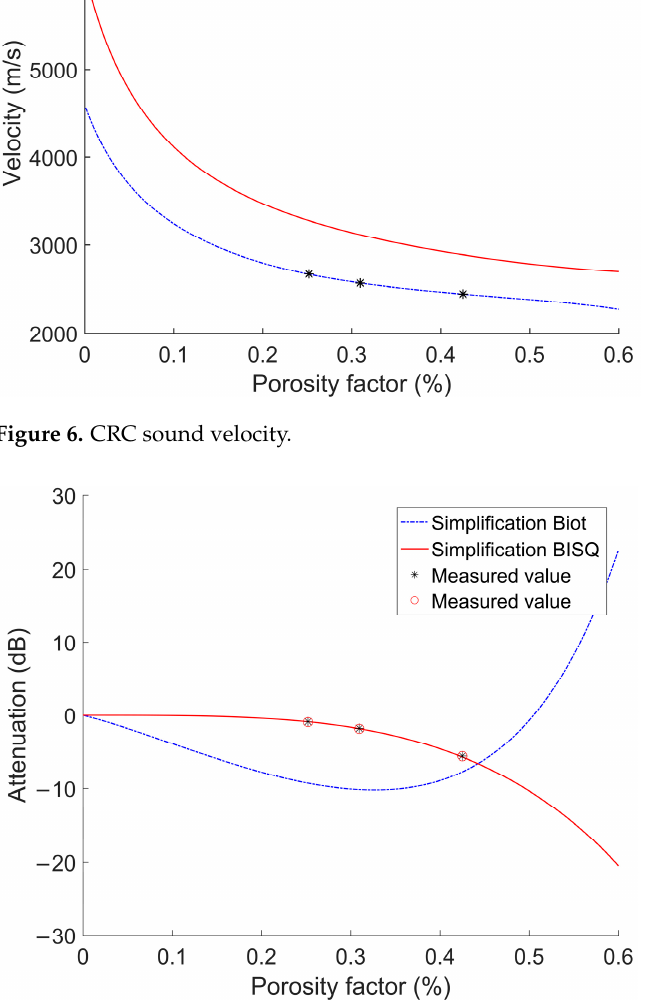
Figure 7. CRC sound attenuation. Figure 7. CRC sound